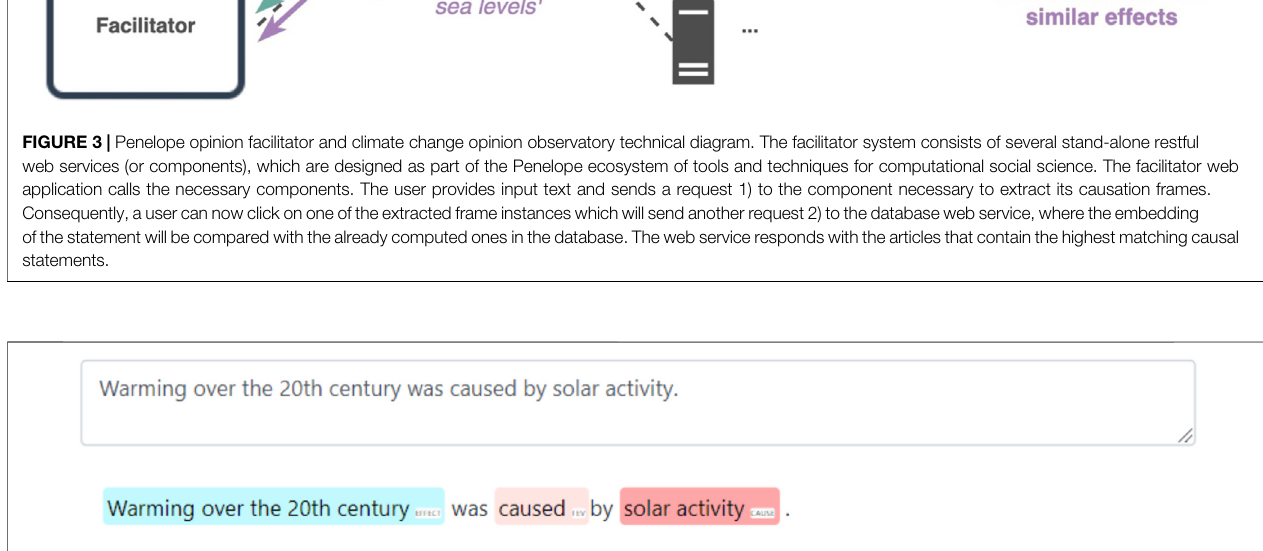
FIGURE 4 | Detail of the Penelope opinion facilitator ’ s user query window. In this case, the reader entered the statement “ Warming over the 20th century was caused bysolar activity. ” The semantic frame extractor then identi fi esthe “ cause ” frame element “ Warming over the 20thcentury, ” theframe evoking element “ caused, ” and the “ effect ” frame element “ solar activity. ” These frame elements can then be used as the start of a search process for alternative causes and effects.